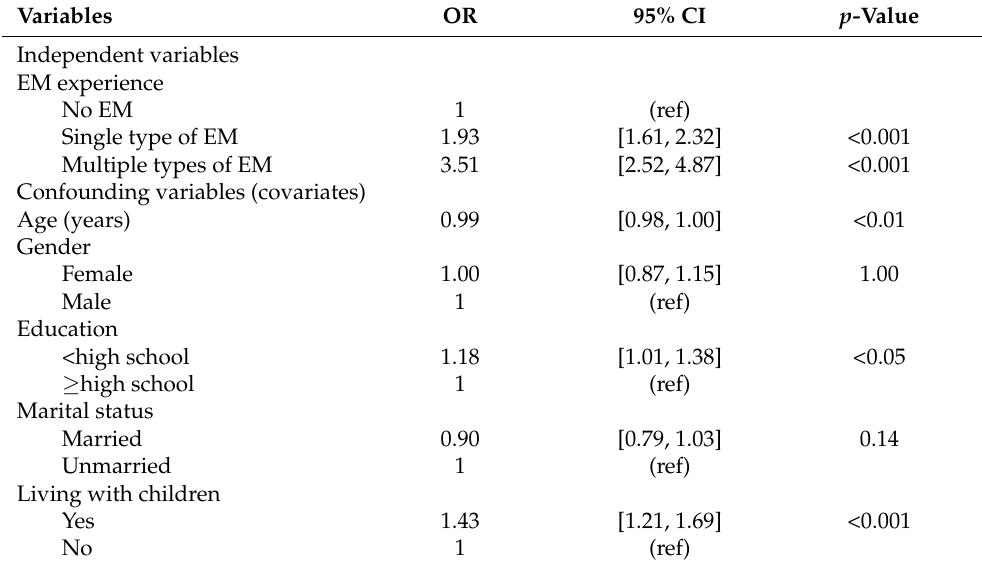
Table 2. Odds ratio of depression by elder mistreatment experience